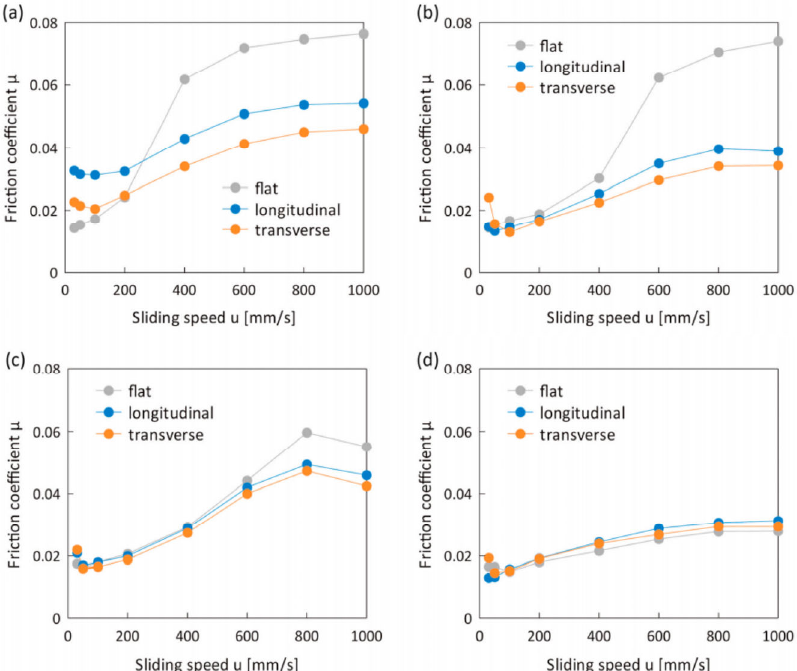
Fig. 16 Comparison of the variations in the friction coefficient among the three types of discs at different sliding speeds for lubricant quantities of (a) 50 μ L, (b) 100 μ L, (c) 150 μ L, and (d) fully flooded conditions [214]. Reproduced with permission from Ref. [214], © Elsevier Ltd., 2021.